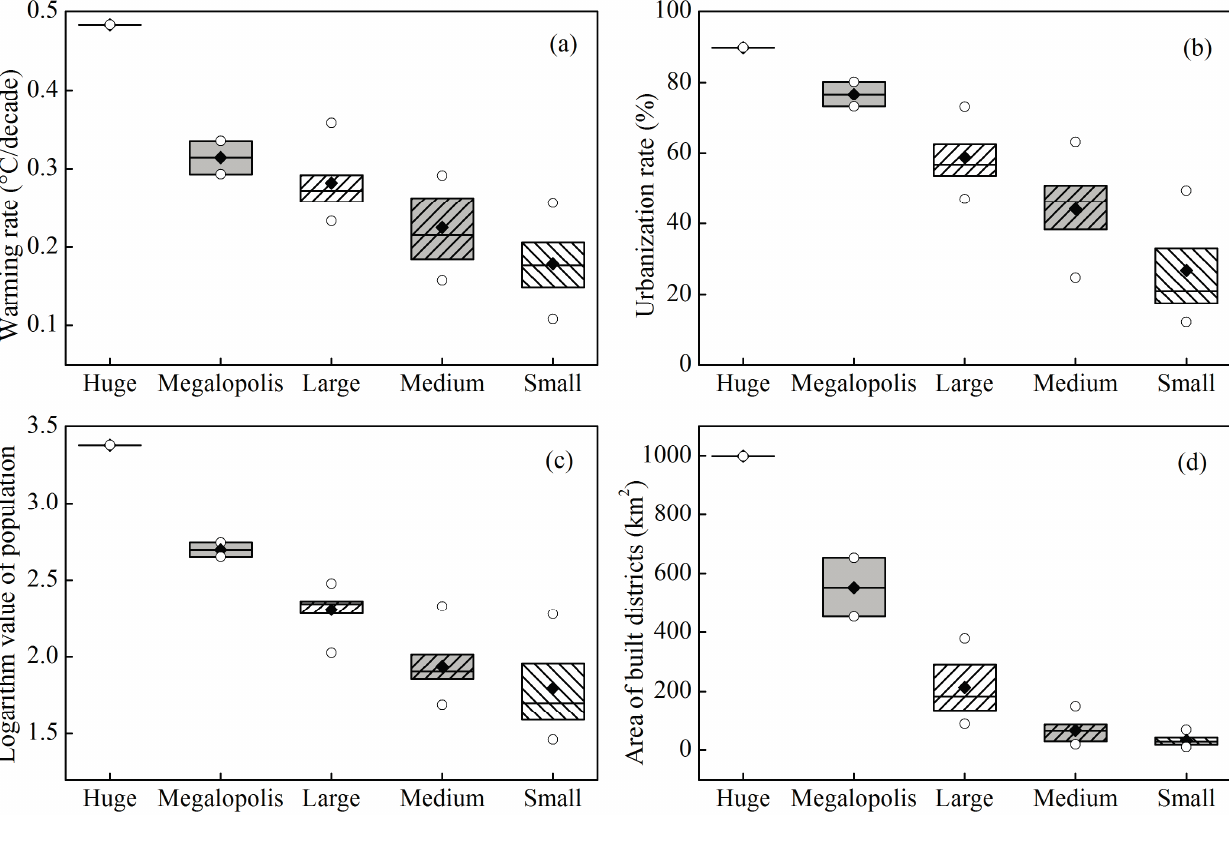
Figure 4. Box plot of five urban sizes for the warming rate ( a ), urbanization rate ( b ), logarithm of the population ( c ), and built-up area ( d ). The box is determined by the 25th and 75th percentiles; the values for the median (horizontal line), mean (solid diamond), minimum, and maximum (hollow circle) are also